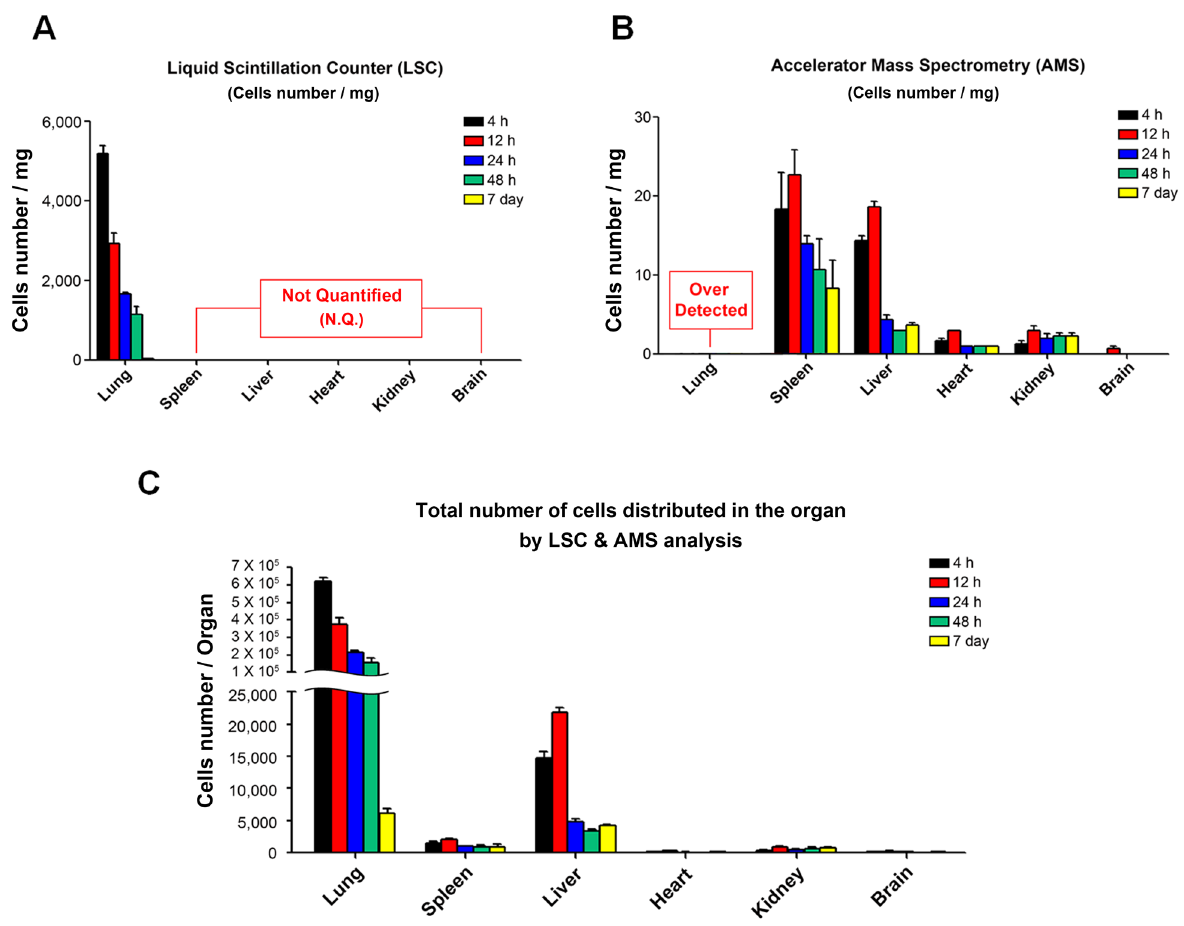
Figure 4. Quntification and distribution results of infused 14 C-labeled AD-MSCs in nude mice using LSC and AMS analysis. ( A ) The distribution of 14 C-labeled AD-MSCs after IV injection in nude mice. 14 C-radioactivity of each organ using LSC. Data were represented as mean cells number/mg. ( B ) Modern carbon (MC) measurement of each organ using AMS. Data were represented as mean cells number/mg. ( C ) Total amount of cells in organs using 14 C radioactivity value from LSC and AMS analysis. All data are expressed as mean ±